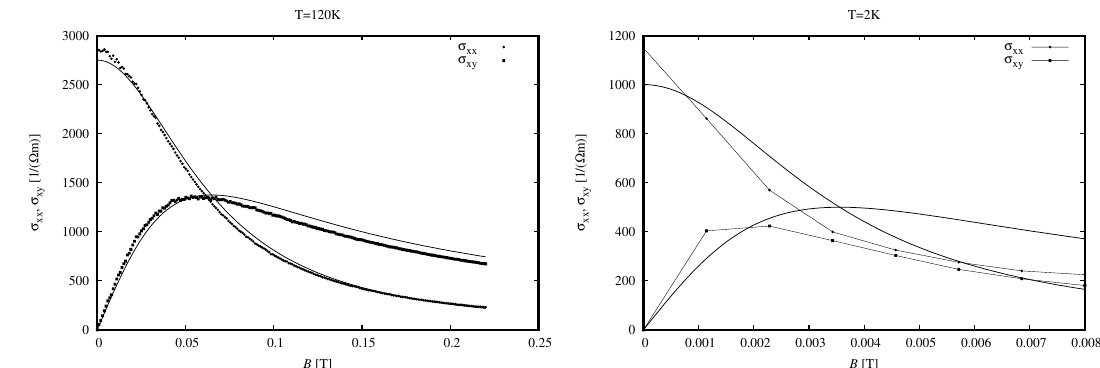
Figure 4. Components of the conductivity tensor at 120 K ( left ) and 2 K ( right ). Points: experimental results; smooth solid lines—fits of Equation (1) with N = 1. Note a different range of B in the two